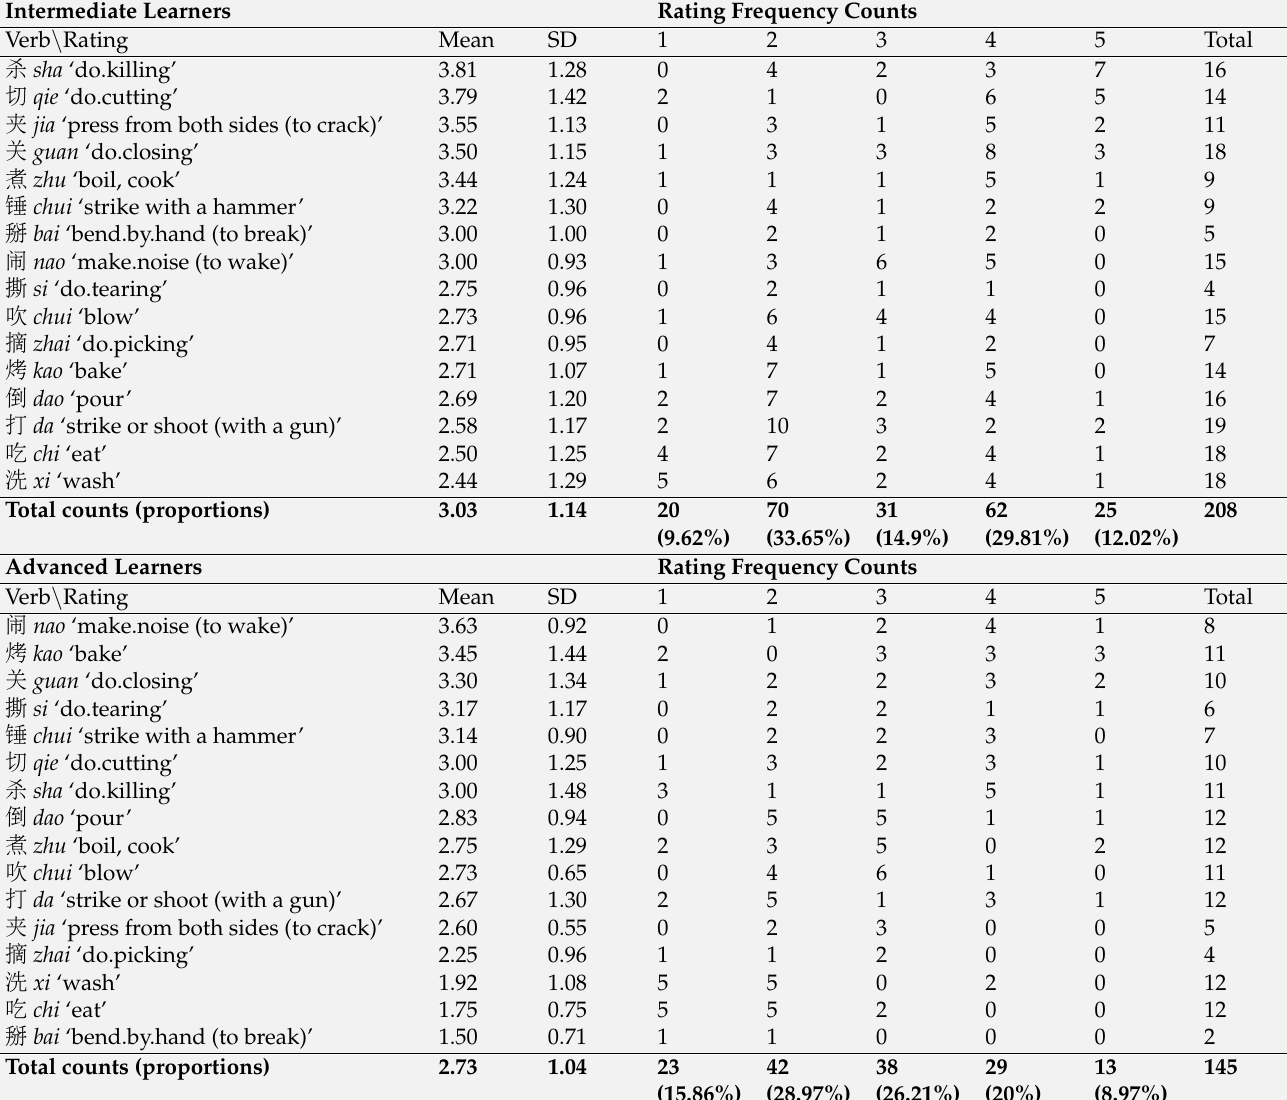
Table 3. Frequency counts, rating means, and standard derivations of the ratings by verb and learner